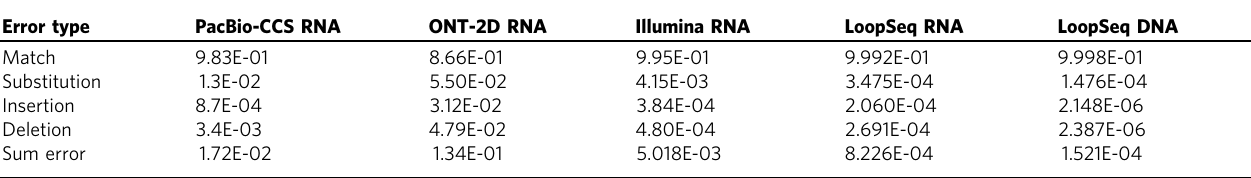
Table 1 Comparison of error rates across different sequencing